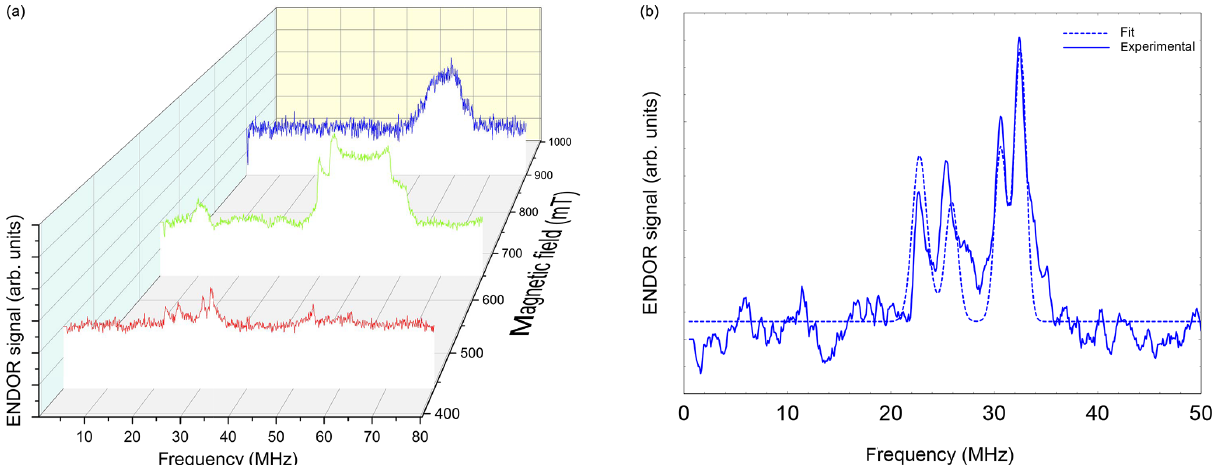
Figure 6. (a) Davies ENDOR spectra of NO@C60-OH1 ( T = 5K, 10mM/CS 2 ) measured as a function of B 0 . Spectra are corrected with respect to different accumulation times for better comparison of spectral patterns. The Davies ENDOR pulse sequence (40–30000–20–200– 40ns, 25µs rf pulse) was identical for all spectra. (b) ENDOR spectrum of NO@C60-OH1 measured at 440mT (see panel a ) together with